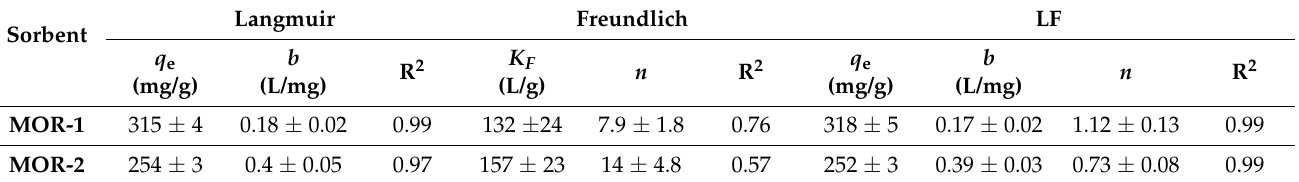
Figure 3. Equilibrium DCF − sorption data for ( a ) MOR-1 and ( b ) MOR-2 materials (pH~7). The solid line represents the fitting of the data with the Langmuir model. Table 2. Modeling parameters for the DCF − removal by MOR-1 and